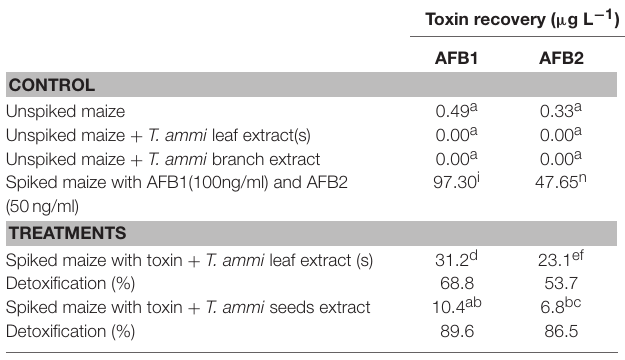
TABLE 2 | In vivo detoxification of AFB1 and AFB2 by aqueous extracts of T. ammi